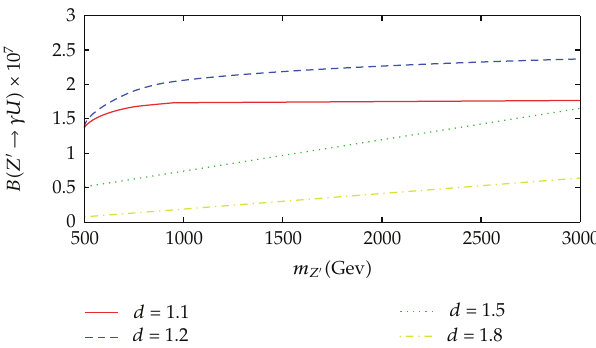
Figure 2: Branching ratio B (cid:4) Z (cid:2) → γU (cid:5) × 10 7 for c v (cid:10) a v (cid:10) 1, Λ (cid:10) 1TeV depending on d (cid:10) 1 . 1 , 1 . 2 , 1 . 5 , 1 . 8 and m Z (cid:2) (cid:10) 0.5–3.0TeV with Γ Z (cid:2) given by the Z (cid:2)